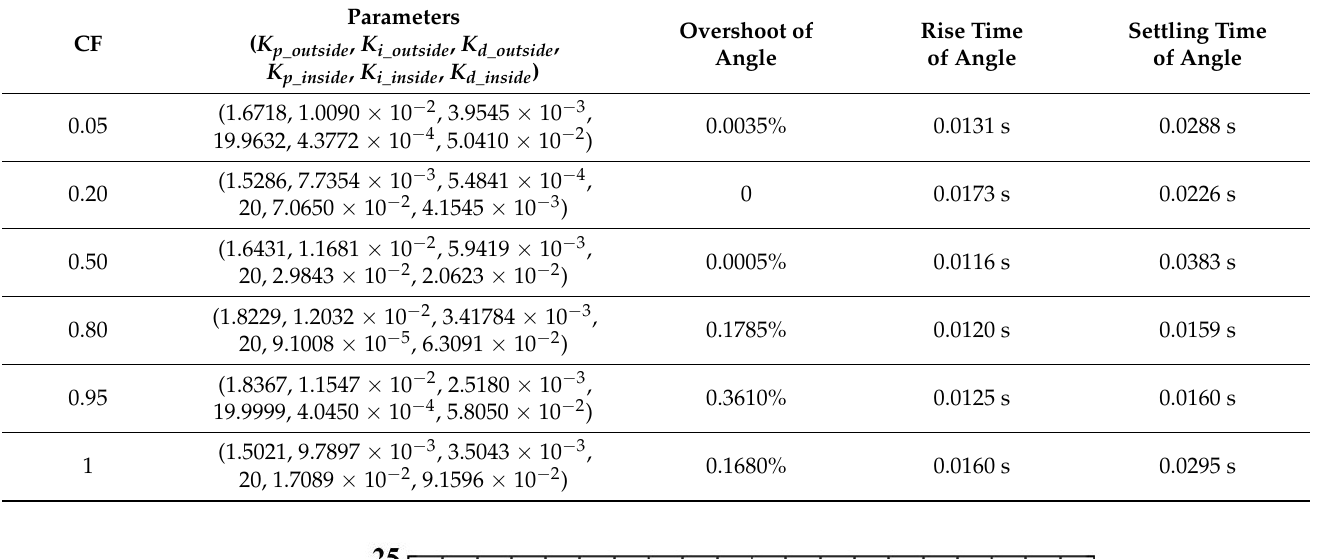
Table 8. Attitude control of balancing robots under CFHBA-PID algorithm with different comple- mentary factors.